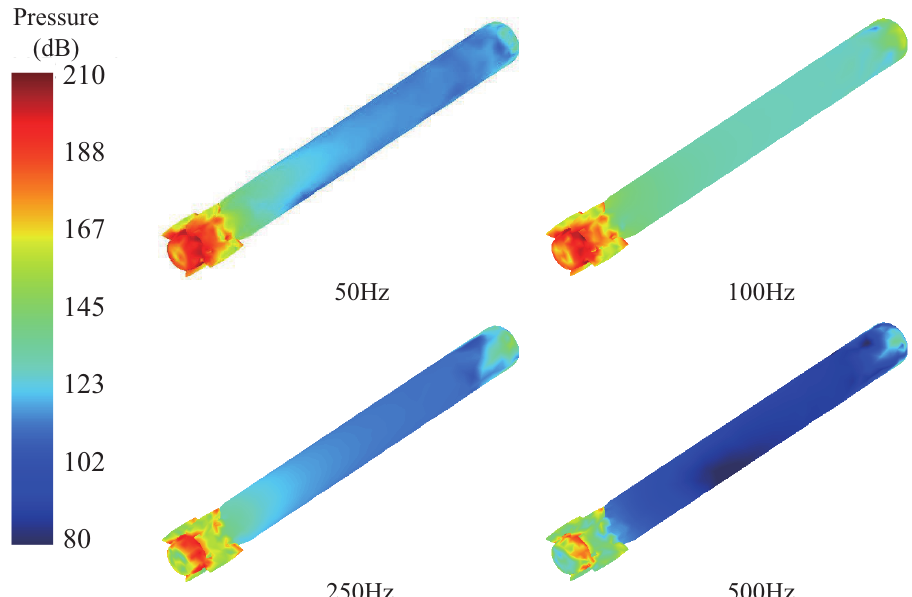
Figure 5. Pulsating pressure on the vehicle